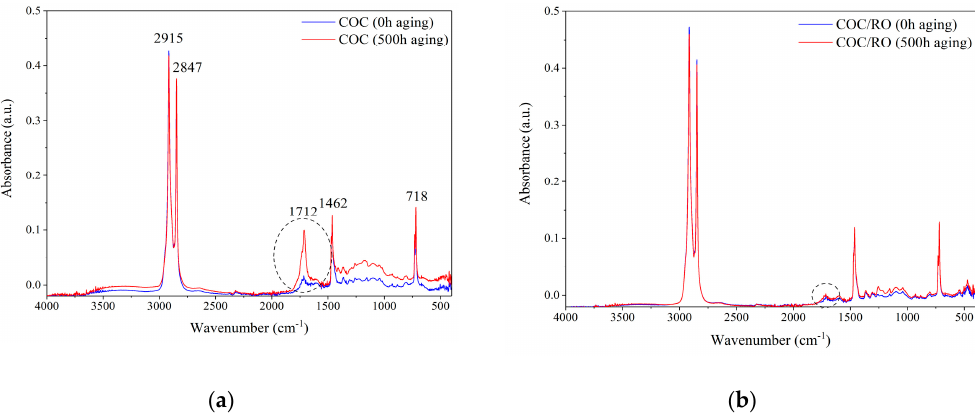
Figure 3. FTIR spectra of the COC copolymer composite ( a ) and COC / RO composite ( b ) before and after aging.